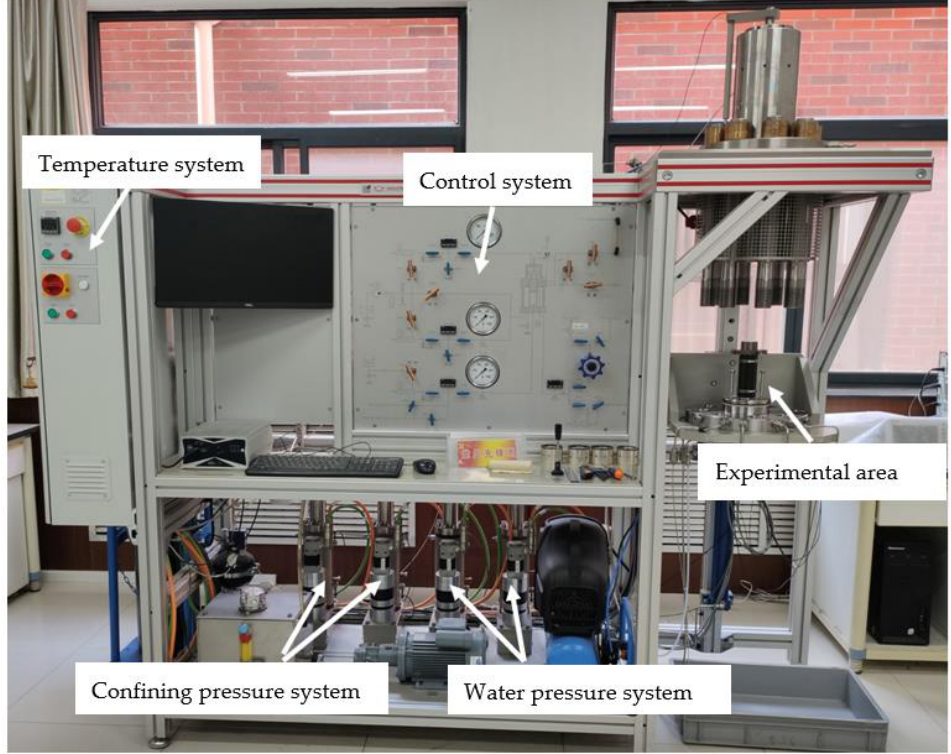
Figure 6. A Rock 600-50-VHT multifield coupling tester made by Top Industrie, France.